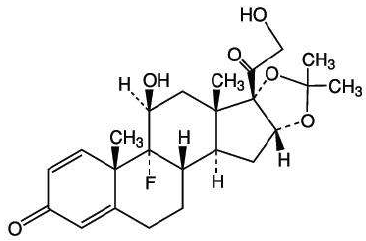
Figure 1. The structure of triamcinolone acetonide.